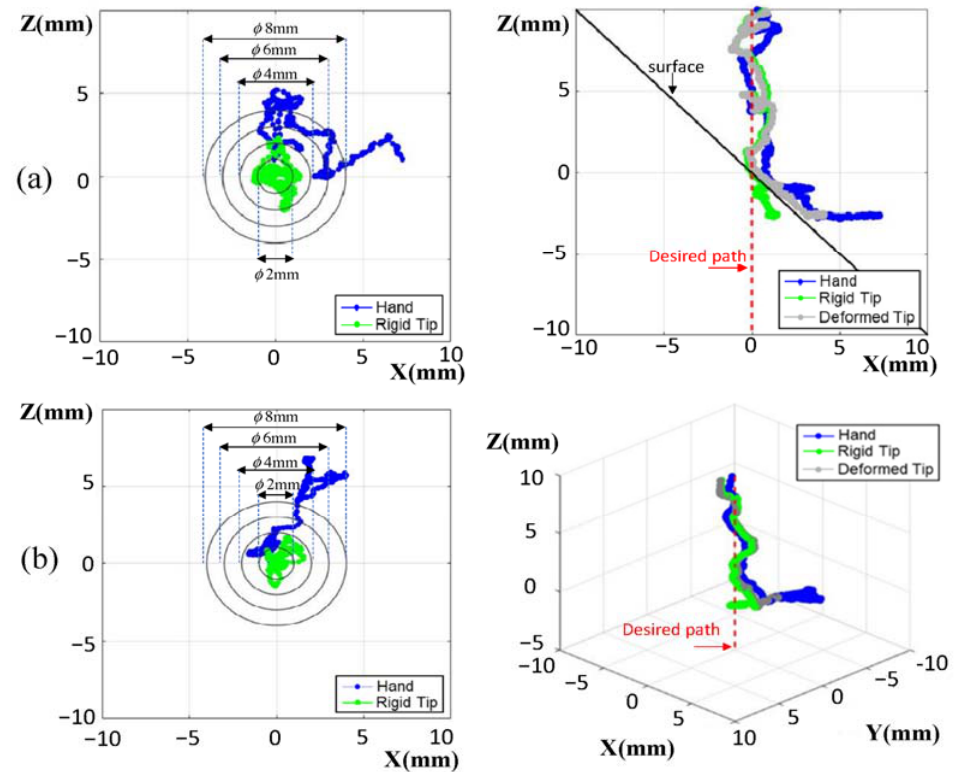
Figure 8. Tool trajectories upon approach to the target entry point without contact compliance ad ‐ justment: ( a ) on the ASTM test jig; ( b ) on the vertebra surface with varying